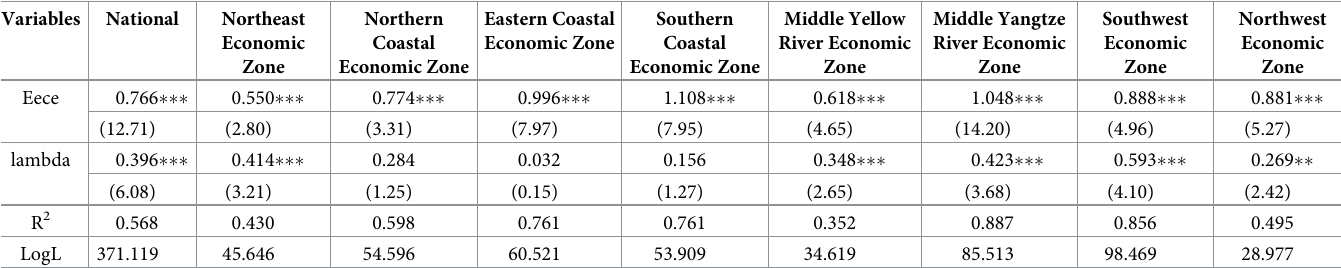
Table 6. Absolute β convergence of the coupling coordination degree of the energy-economy-carbon emission system.